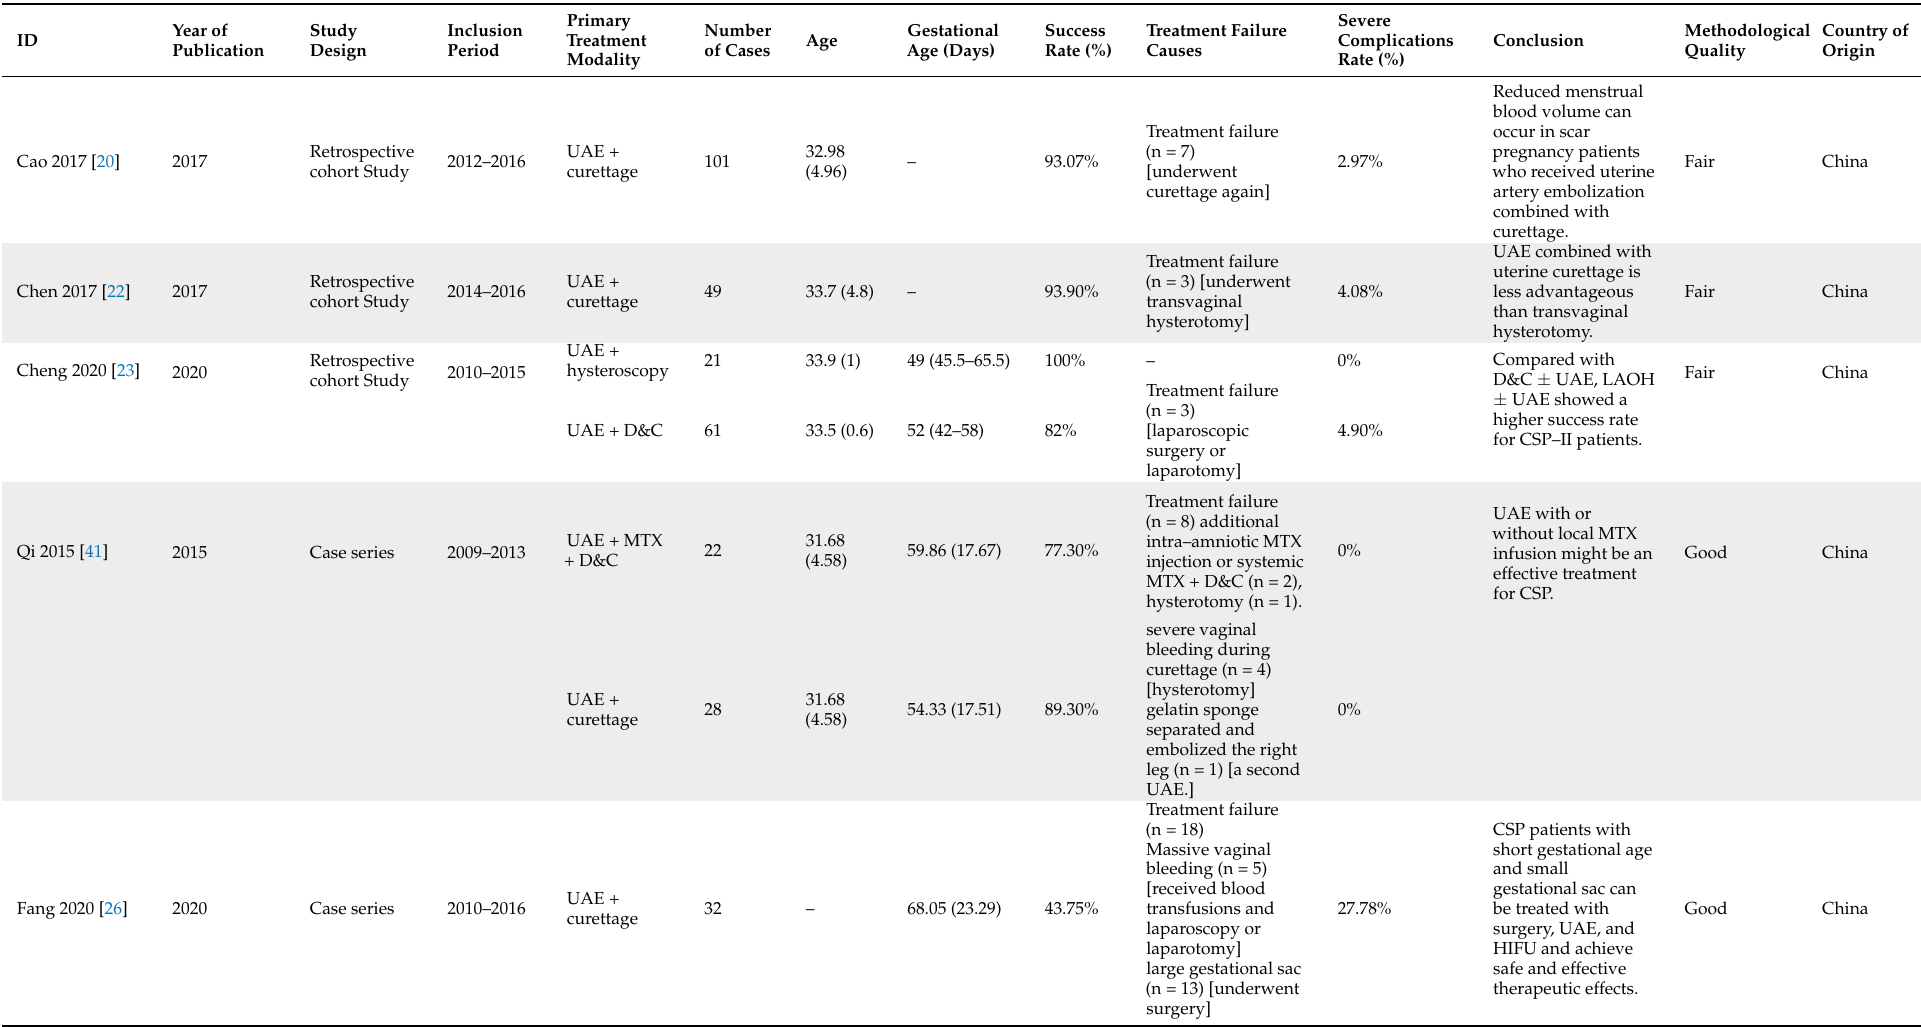
Table 1. Shows the summary and baseline characteristics of the included